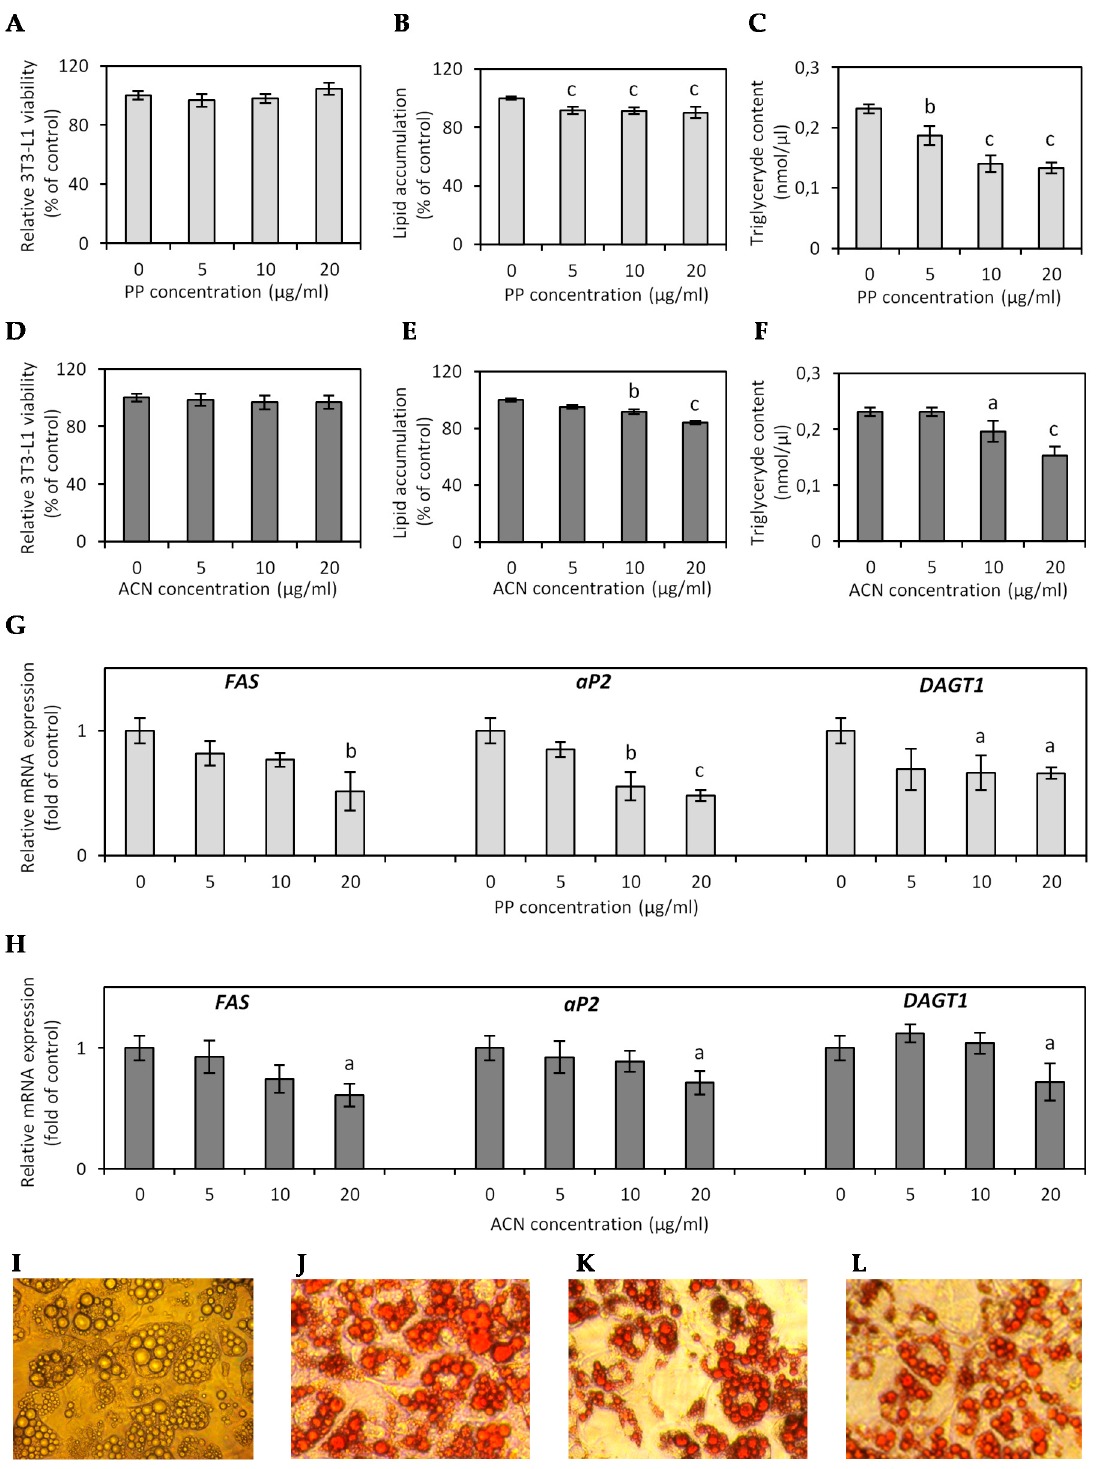
Figure 2. Effect of non-anthocyanin polyphenol (PP) fraction and anthocyanin (ACN) fraction on cell viability ( A , D ), lipid accumulation ( B , E ), triglyceride content ( C , F ), and lipogenic gene expression ( G , H ) in hypertrophied 3T3-L1 adipocytes. Data are the mean values ± SD ( n = 3). a p < 0.05, b p < 0.01, c p < 0.001. The photos present hypertrophied 3T3-L1 adipocytes on day 12 after differentiation ( I ), Oil Red-stained hypertrophied 3T3-L1 adipocytes non-treated ( J ), and treated with PP fraction ( K ) and ACN fraction ( L ) at the concentrations of 20 µg/mL. The cells were photographed at a magnification of 100×.